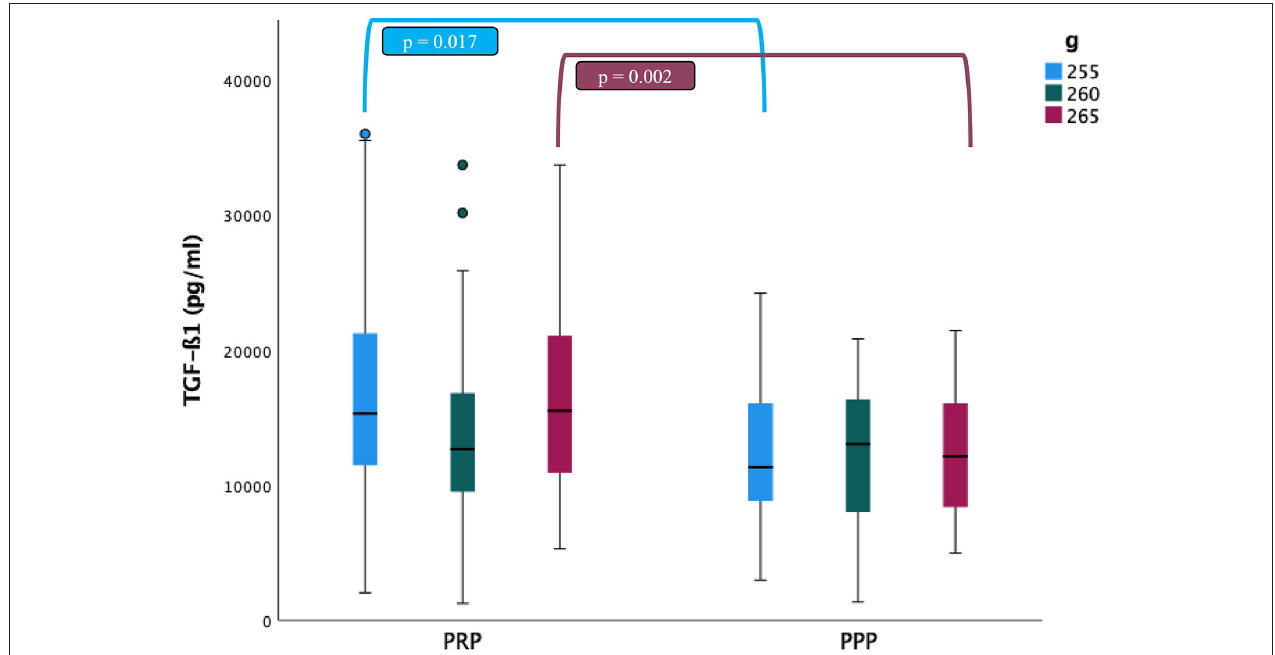
FIGURE 4 | Comparison of the transforming growth factor β 1 (TGF-ß1) concentrations (mean ± SD) in cat ( n = 30) between PRP and PPP fractions according to the three centrifugation protocols (g: 255, 260 and 265 in 10min). • : Outlyers data included in the statistically